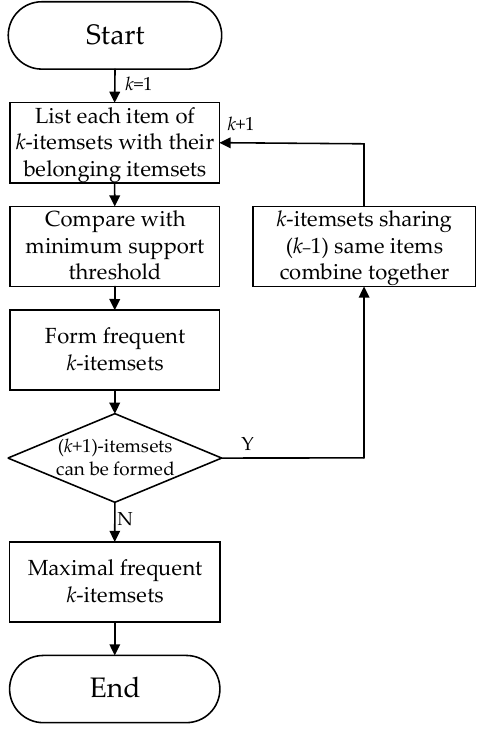
Figure 3. Procedure of the Eclat algorithm.